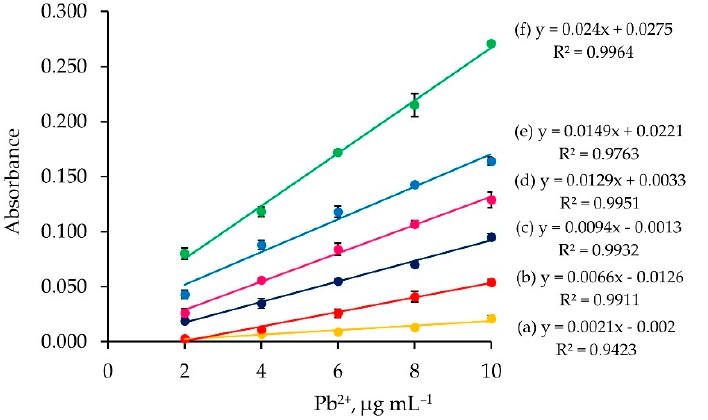
Figure 4. Calibration graphs obtained for different loading times: (a) 2 min; (b) 3 min; (c) 5 min; (d) 7 min; (e) 10 min; and (f) 15 min.